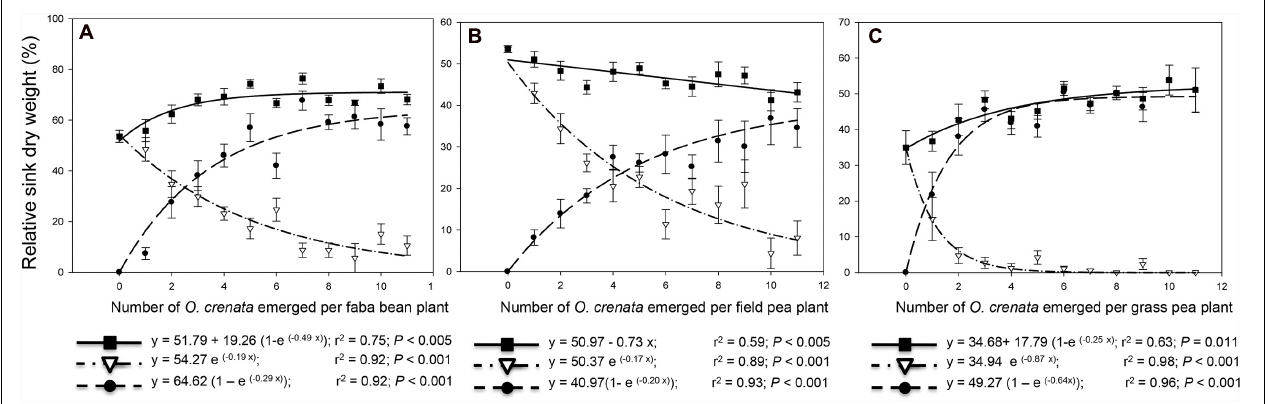
FIGURE 3 | Relationship between relative sink weight (ratio of sink weight to total complex dry weight) and infection severity measured as O. crenata emergence per host plant. Combined sink (host seed + O. crenata ) relative weight ( (cid:4) ), host seed relative weight ( (cid:79) ), O. crenata relative weight (